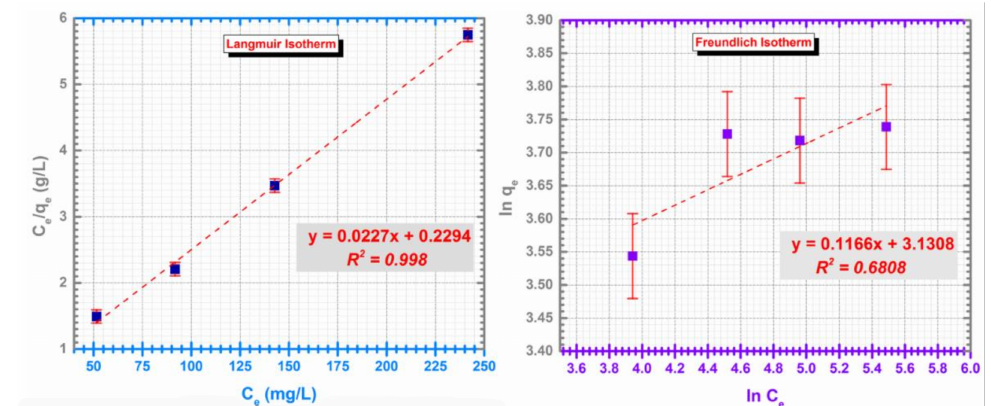
Figure 8. Langmuir isotherm ( left ) and Freundlich isotherm ( right ) for the adsorption of Cd (II) on CF@CMC.